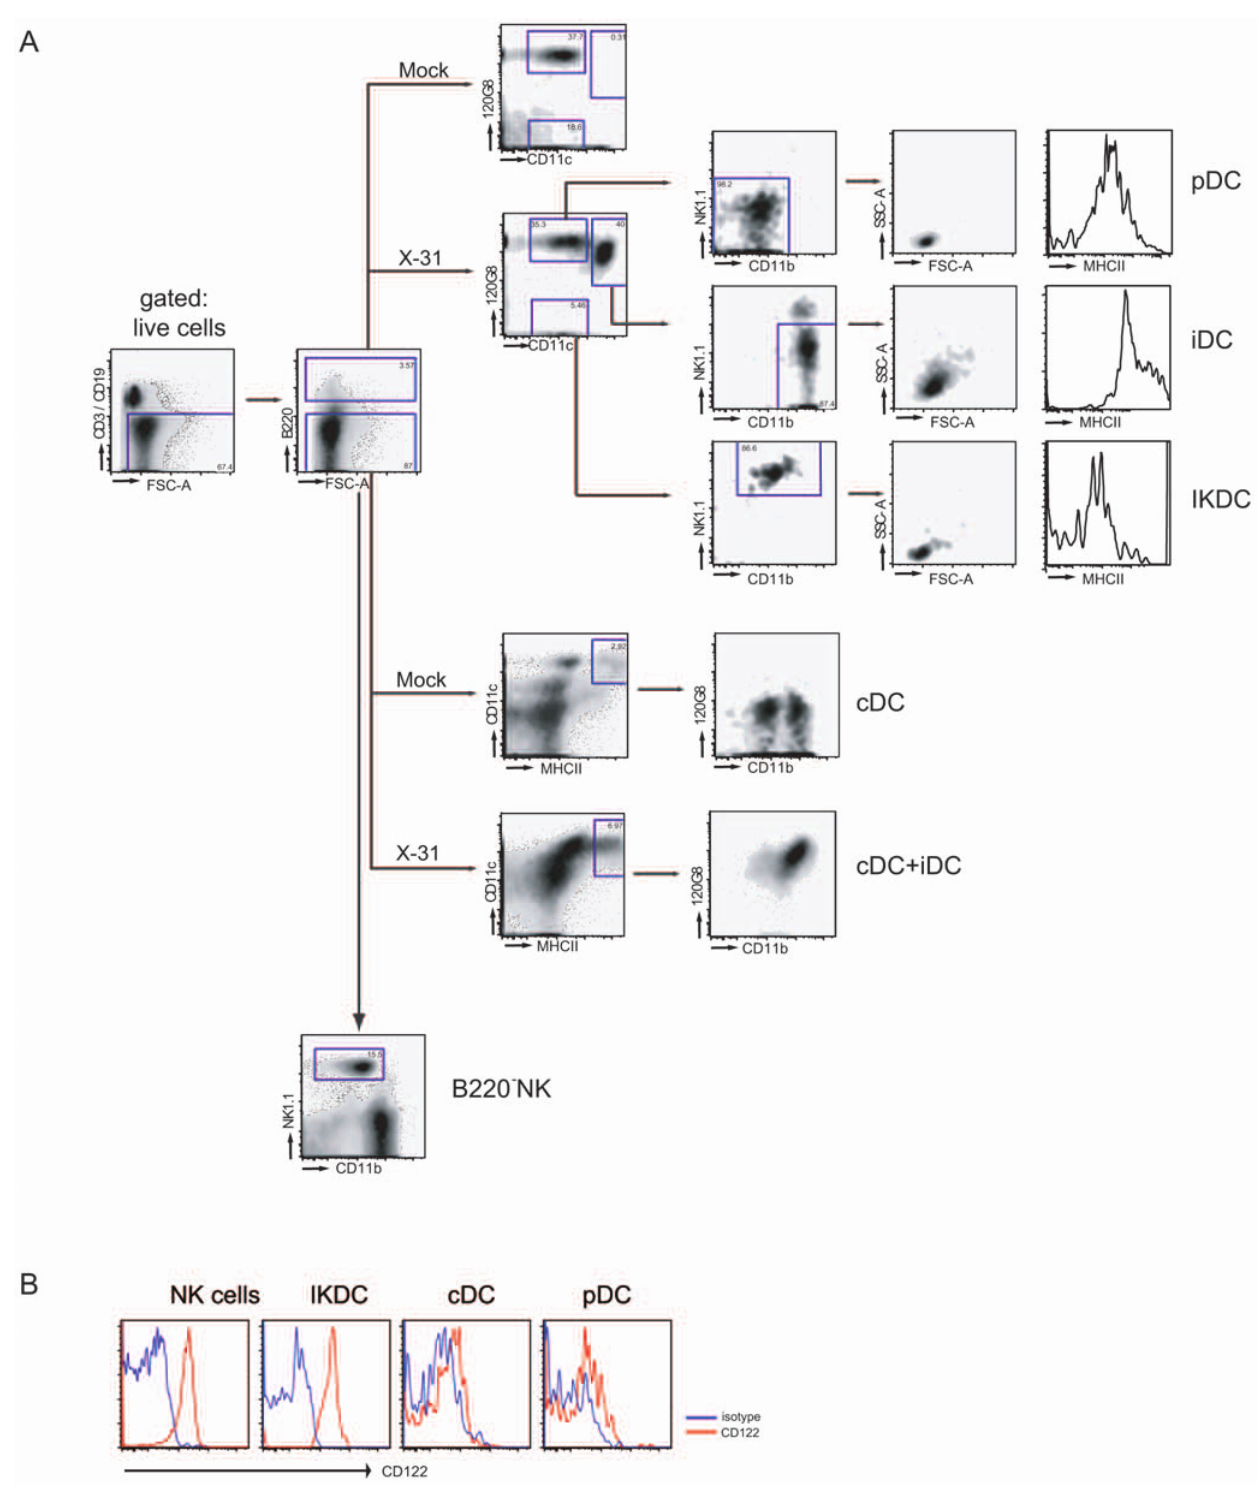
Figure 1. Identification of NK and DC subsets cell in lung tissue. (A) 10-color flowcytometric analysis of lung tissue. A CD3/CD19 negative population was gated from live, low autofluorescent cells in the lung. The B220 high population was further subdivided based on CD11c, 120G8, CD11b and NK1.1. After influenza virus infection, three populations could be clearly demarkated.CD11c interm 120G8 low NK1.1 hi IKDCs, CD11c interm 120- G8 hi NK1.1 lo CD11b lo pDCs and CD11c hi 120G8 hi CD11b hi MHCII hi iDCs. The iDC population was completely absent in steady state condition. In the B220 low population cDCs were gated as MHII hi CD11c hi and NK cells as a NK1.1 hi population expressing intermediate levels of CD11b. (B) Histograms demonstrating CD122 expression on NK cells, IKDCs and cDCs. The grey histogram represents isotype control, black histogram represents CD122 expression. Representative of 3 experiments.